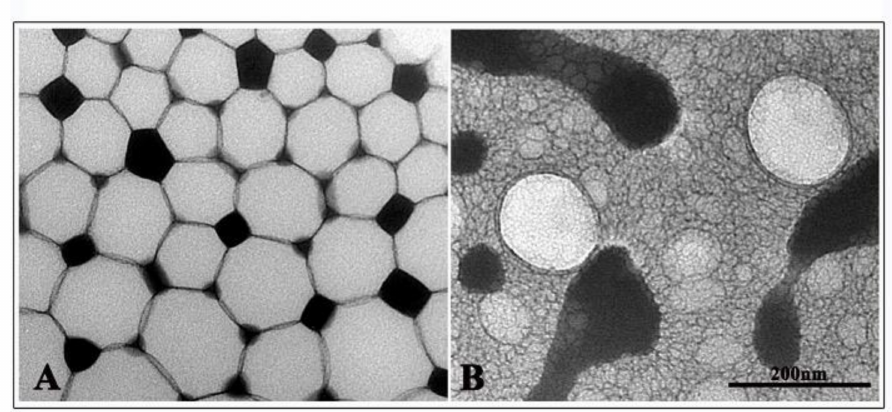
Figure 2. Transmission electron microscopy micrograph of NR (panel A ) and NT (panel B